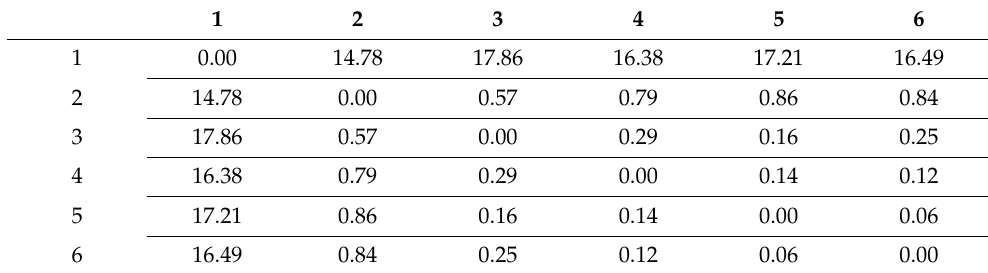
Table 1. Distress target distance situation.